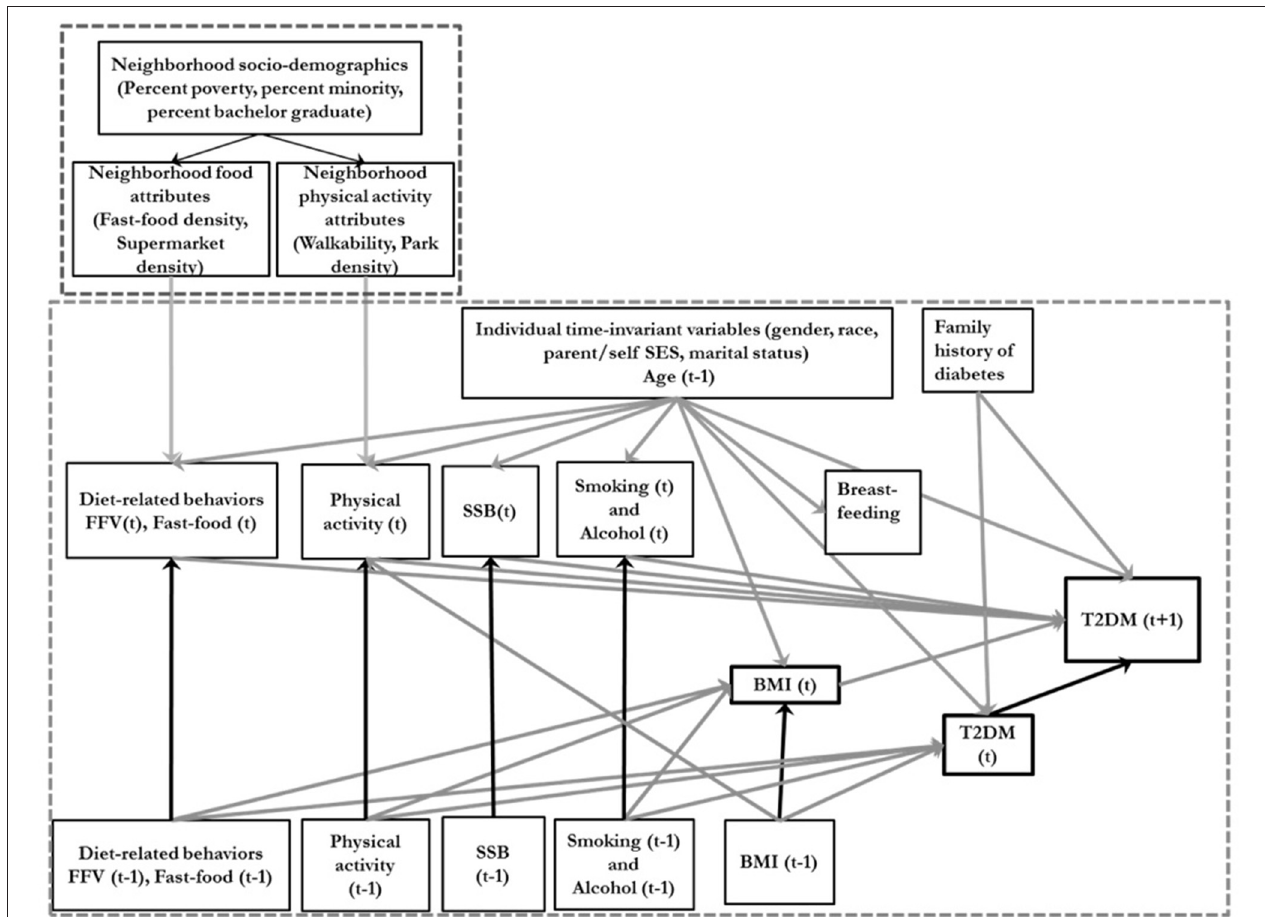
FIGURE 1 | Conceptual directed acyclic diagram underlying the data-generating process. SSB, sugar-sweetened beverage consumption; BMI, body mass index; FFV, Fresh fruit and vegetable consumption; T2DM, type 2 diabetes; Ado, Adolescence. T is an index of time. The smaller dotted square represents the neighborhood variables and the larger dotted square represents the individual level